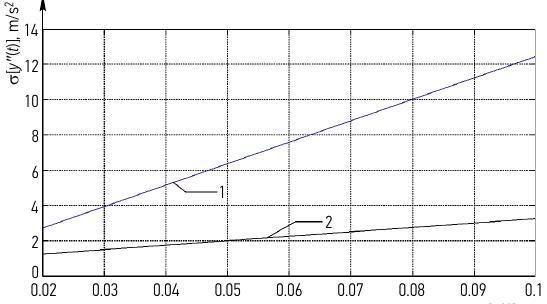
Fig. 4. Standard deviations of the theoretical second derivative (car acceleration), numerically calculated by using the classical (1) and offered (2)